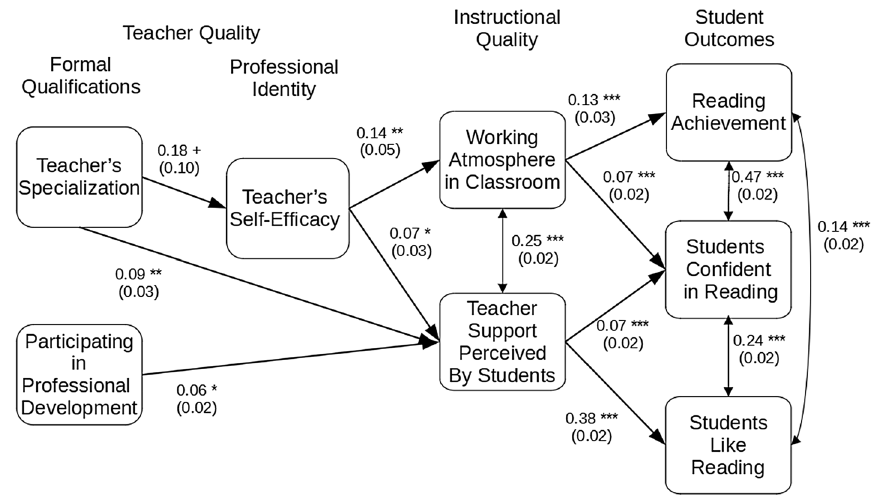
Fig. 3 Path analysis model for Denmark